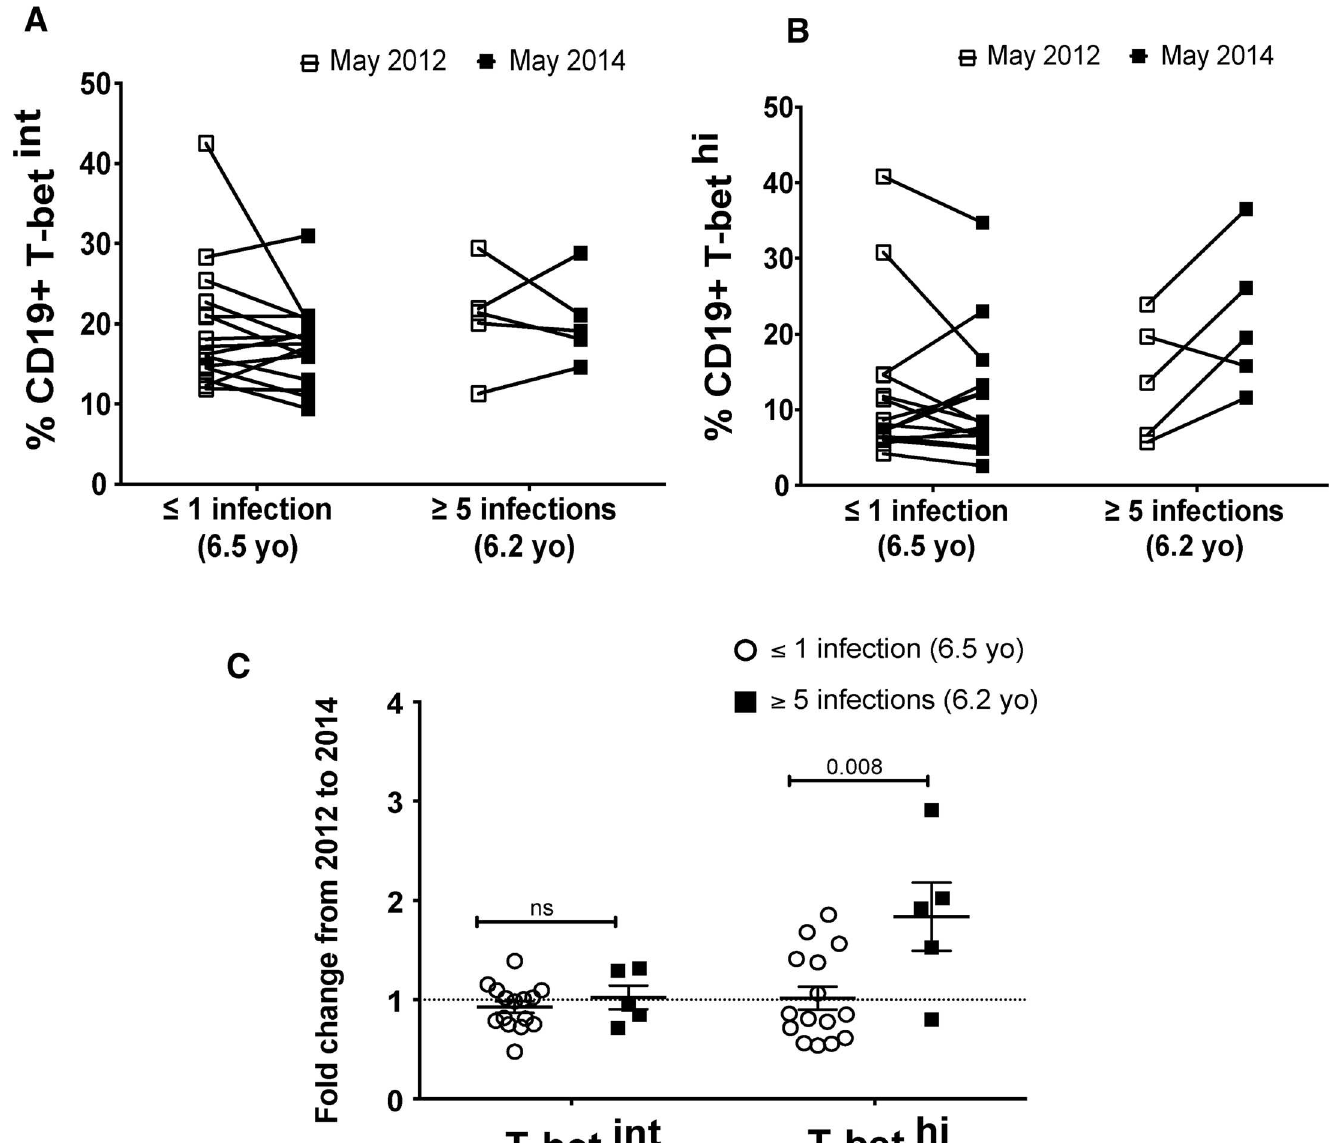
Fig 9. The frequency of febrile malaria episodes associateswith increased T-bet hi B cells. Percent of CD19 + B cells that were ( A ) T-bet int or ( B ) T- bet hi before and after a two-year periodof intensiveclinicalsurveillance in age-matched childrenwho had either (cid:20) 1 (n = 15) or (cid:21) 5 (n = 5) febrile malaria episodesduringthe same period. ( C ) Fold changeof T-bet int and T-bet hi CD19+ B cells from before to after the two-year surveillance period in children who had either (cid:20) 1 or (cid:21) 5 febrile malaria episodes.p values were determined by pairedStudent’s t test with Bonferroni adjustmentswhere appropriate. **** P < 0.0001, *** P < 0.001, ** P < 0.01, * P < 0.05,ns = not significant.